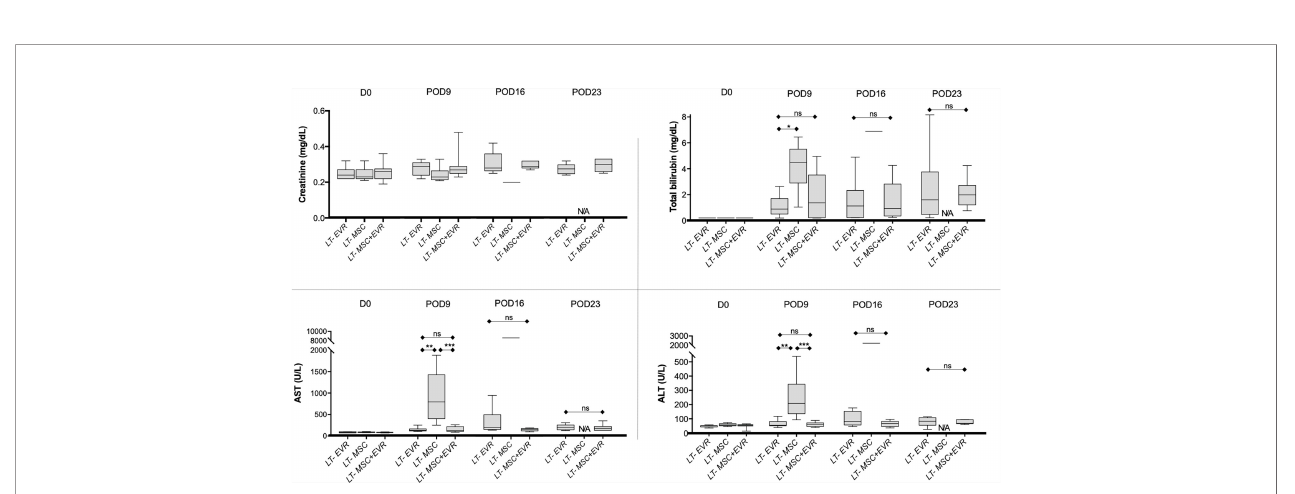
FIGURE 6 | Levels of creatinine, total bilirubin, aspartate aminotransferase (AST) and alanine aminotransferase (ALT) in the blood at D0, post-operative 9, 16 and 23 in recipients after liver transplantation. Plots display the median (25th and 75th percentiles) of the distributions (boxes), and whiskers extend to the minimal and maximal values. The Kruskal-Wallis test followed by Dunn ’ s multiple was used when comparing three groups, and the Mann-Whitney test was carried out when comparing just two groups at a timepoint. At D0 n = 10 per group, at D9 n = 9/9/10, at D16 n = 9/1/10 and at D23 n = 9/0/10 for LT-EVR/LT-MSC/LT-MSC+EVR groups , respectively. (*P < 0.05, **P < 0.01 ***P < 0.001; ns, P > 0.05; ALT, alanine aminotransferase; AST, aminotransferase; D, Day; EVR, Everolimus; MSC, mesenchymal stromal cells; POD, post-operative